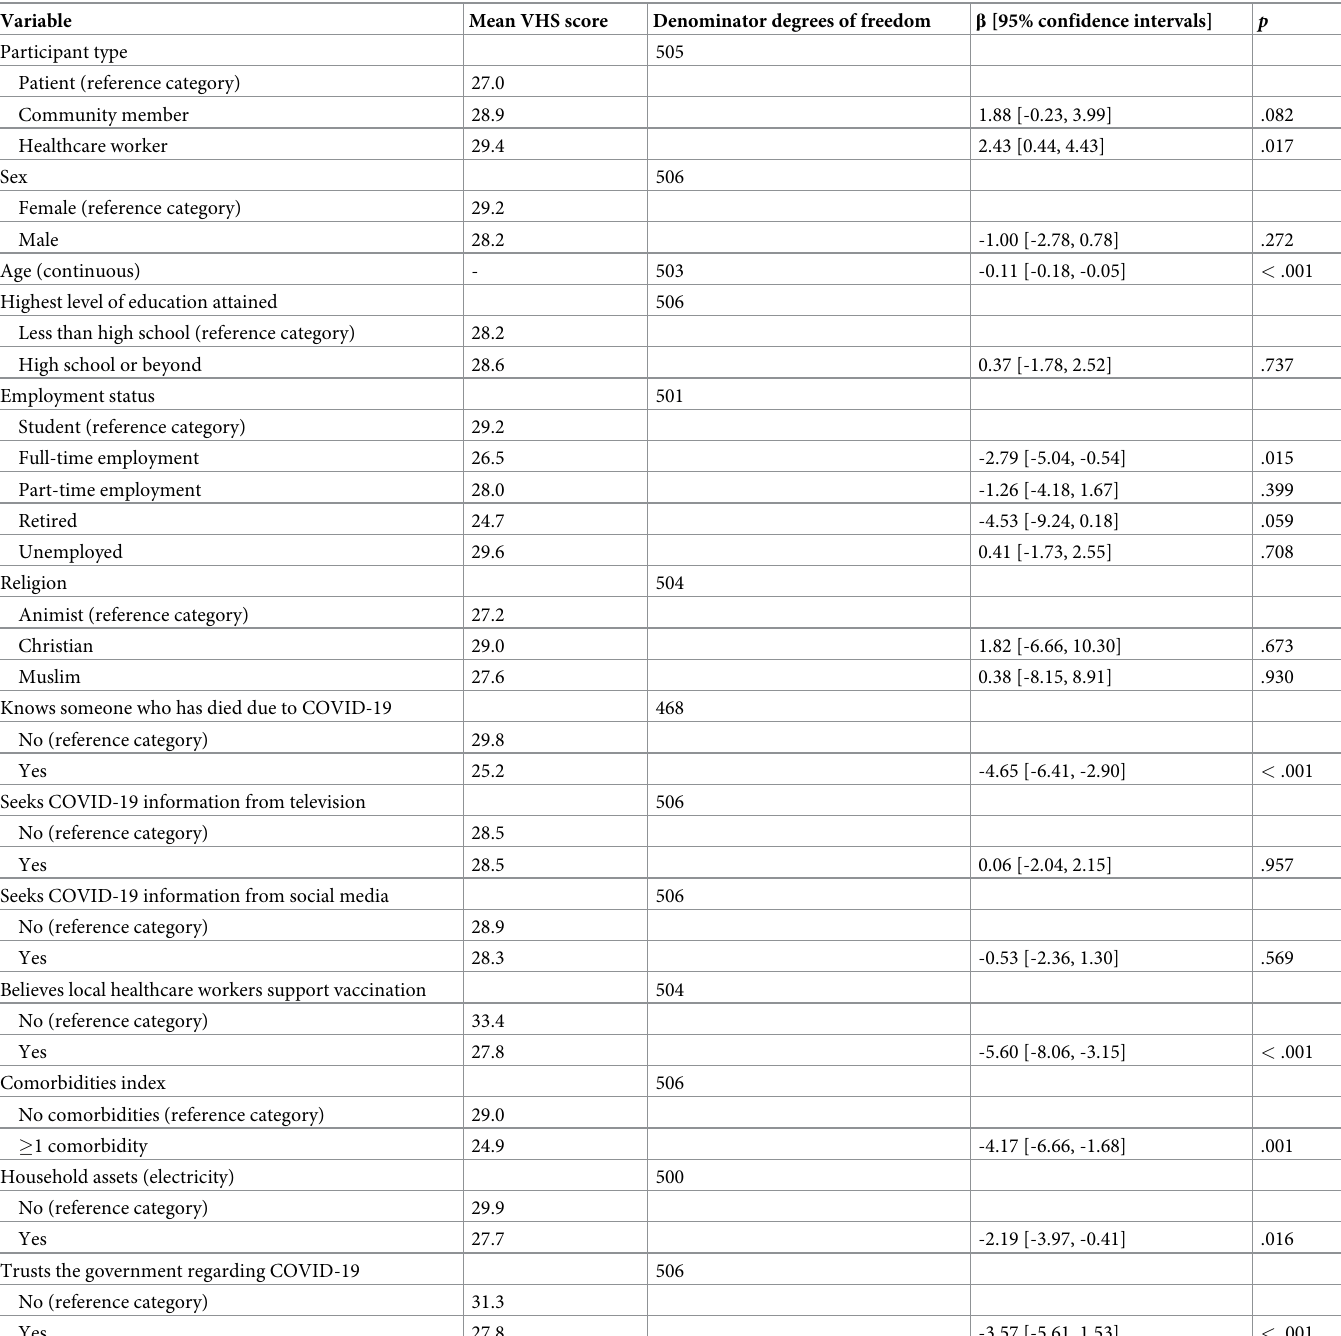
Table 3. Univariable linear regressions evaluating variables associated with vaccine hesitancy in